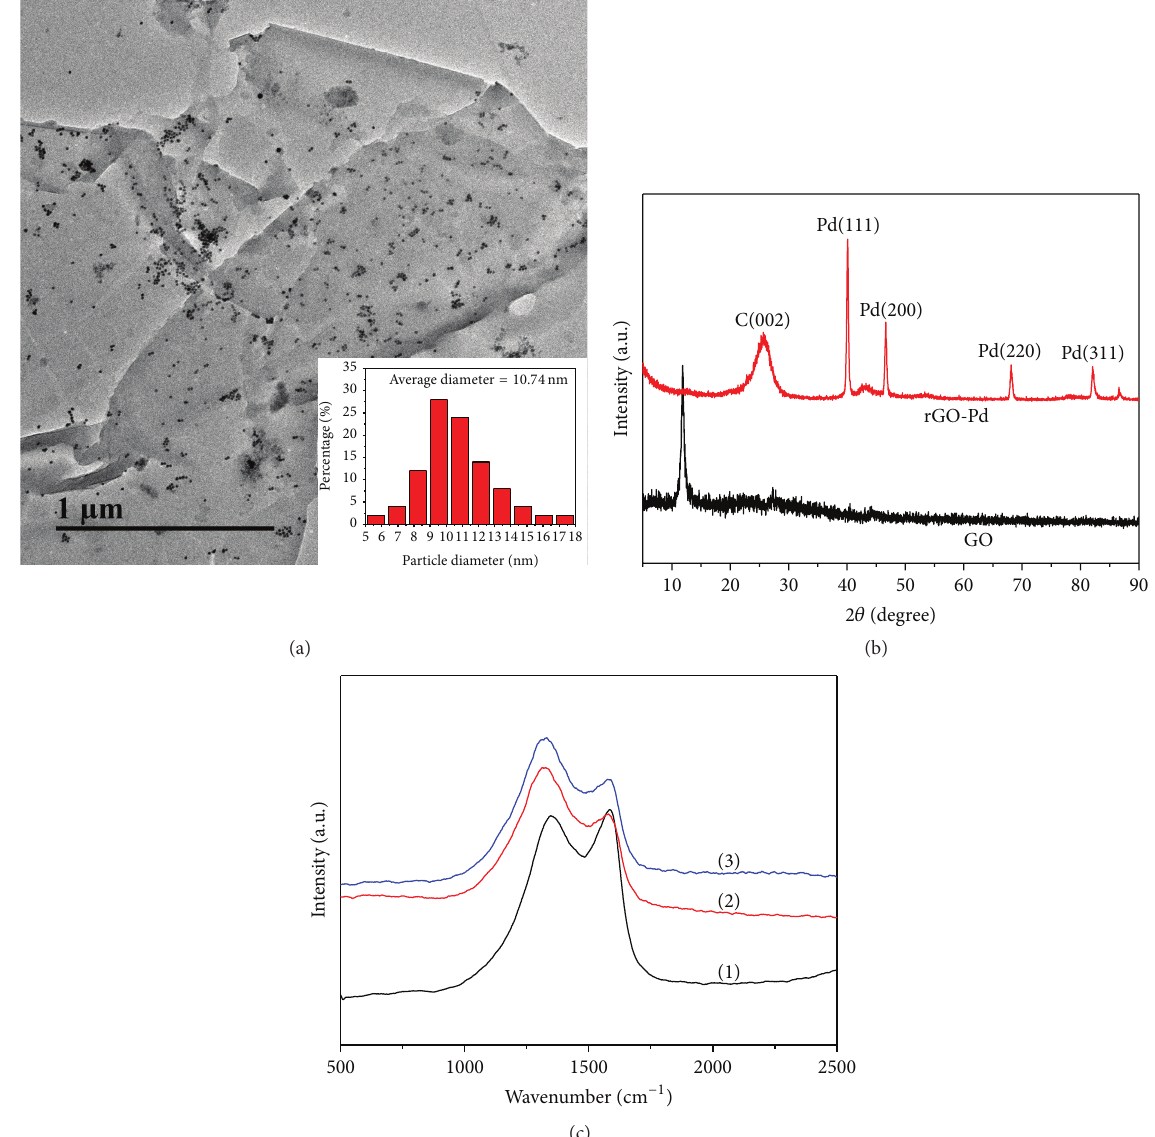
Figure 2: (a) TEM image of rGO-Pd hybrid, inset: diameter distribution of Pd nanoparticles; (b) XRD patterns of GO and rGO-Pd; (c) Raman spectra of (1) GO, (2) rGO, and (3) rGO-Pd